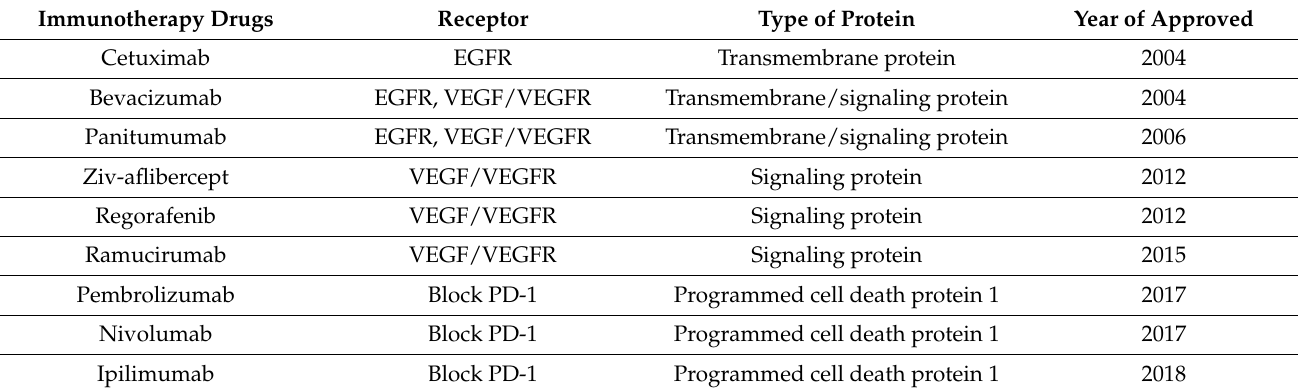
Table 2. The USA-FDA approved immunotherapy drugs for colorectal